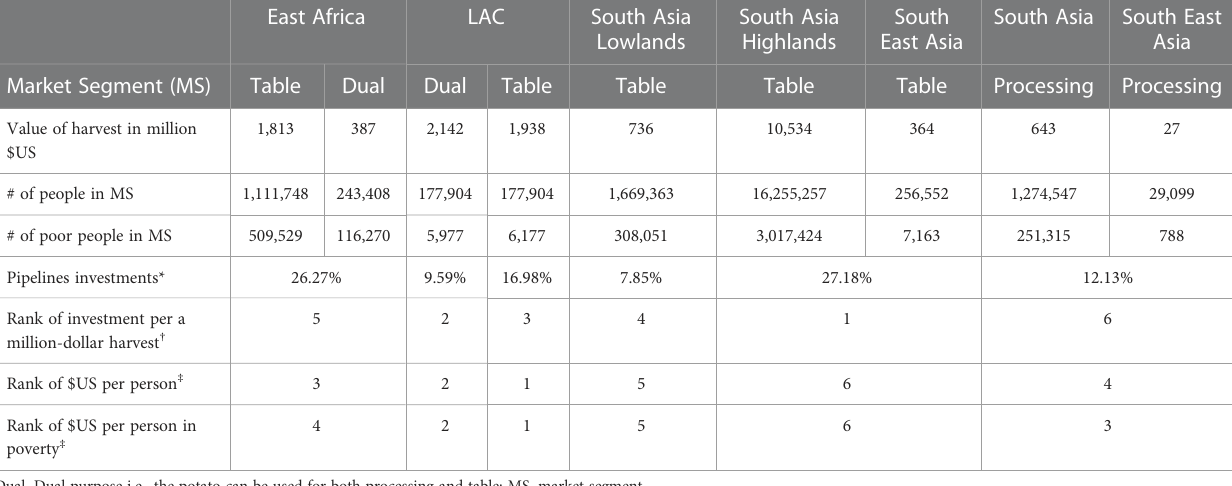
TABLE 4 Size of potato market segments and potential poverty impact in the